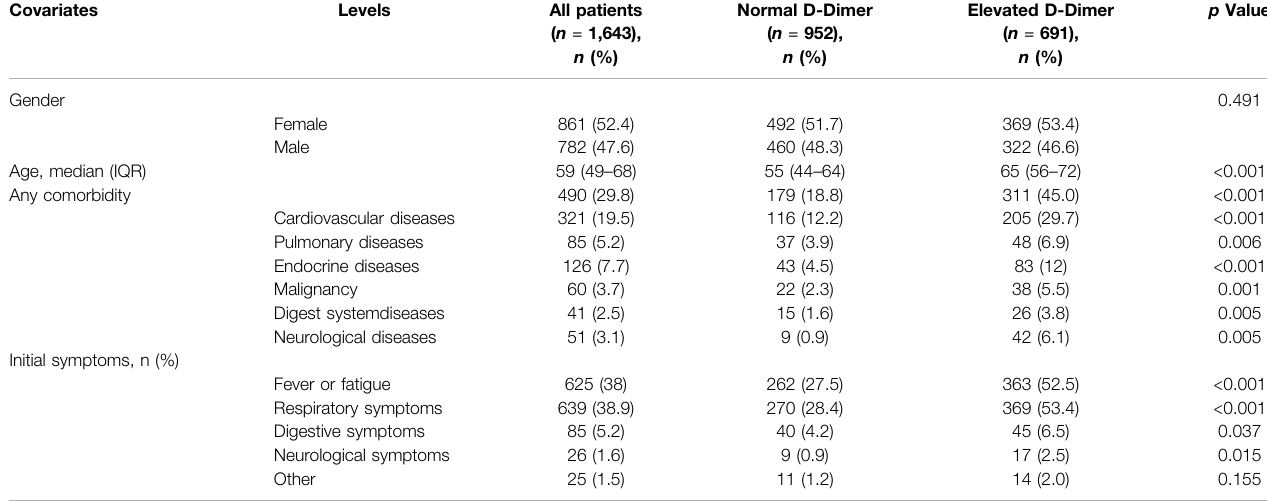
TABLE 1 | Demographic characteristics and symptoms of 1,643 patients with COVID-19. Covariates Levels All patients